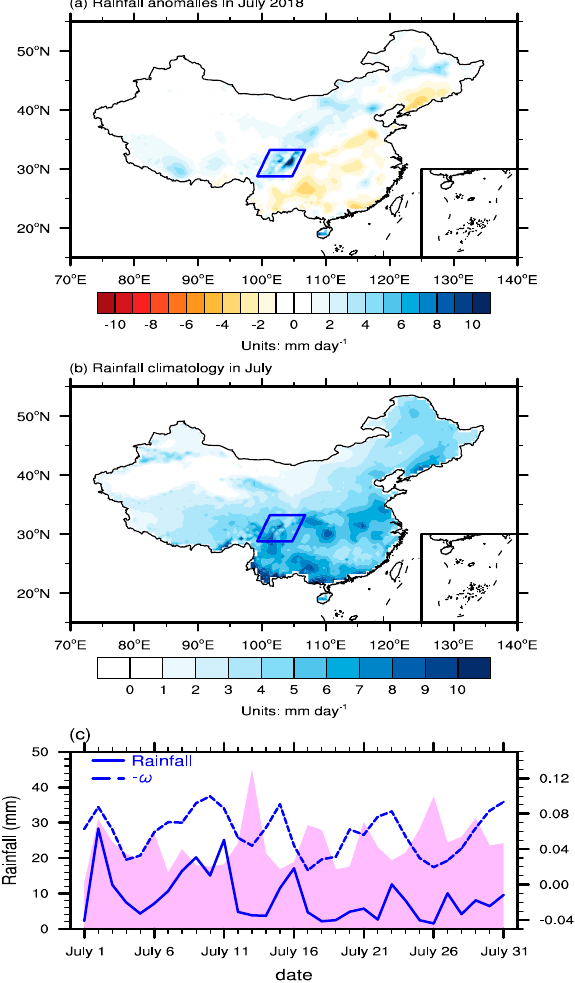
Figure 1. ( a ) Rainfall anomalies in July 2018 [Shading interval (SI) = 1 mm day − 1 ]; ( b ) climatology of rainfall in July (SI = 1 mm day − 1 ); ( c ) time series of daily mean rainfall in July 2018 (blue solid line, unit: mm) and daily historical maximum rainfall in July (shading, unit: mm) averaged over the Sichuan Basin (the blue parallelogram in Figure 1a or 1b). The blue dashed line in ( c ) denotes the area averaged 500 hPa vertical velocity (omega, unit: Pa s − 1 ) over regions surrounding the Sichuan Basin, China (see text for details). Note that − 1 was multiplied to omega for visual purposes.